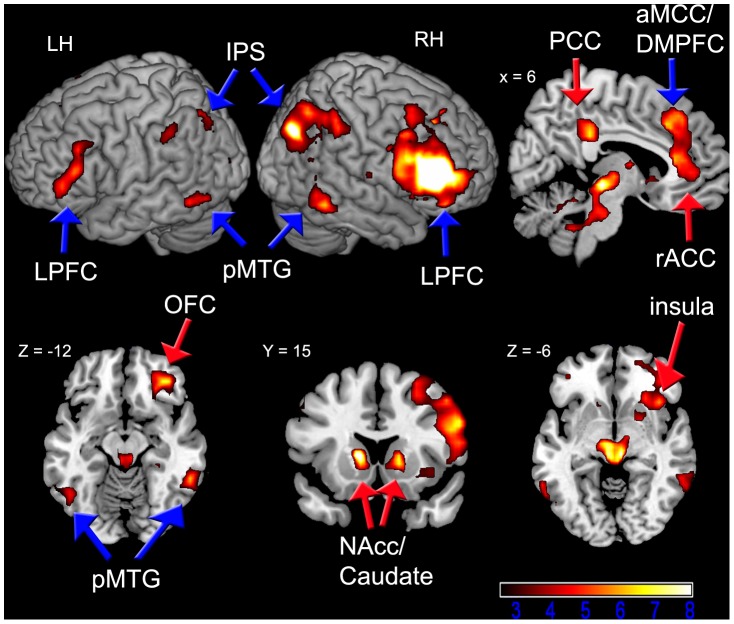
Regions Exhibiting Functional Connectivity with the IFS Across the Entire Time-Course (Z>2.57, p<.05 FWE cluster corrected for the whole-brain).Rule areas (blue arrows) include bilateral lateral prefrontal cortex (LPFC), anterior mid-cingulate cortex/dorsomedial prefrontal cortex (aMCC/DMPFC), posterior middle temporal gyrus (pMTG), and intraparietal sulcus (IPS). Reward areas (red arrows) include rostral anterior and posterior cingulate cortices (rACC, PCC), orbitofrontal cortex (OFC), caudate/nucleus accumbens (NAcc), and insula. The color scale denotes t-values, and the numerical values above the images correspond to MNI coordinates. For axial and coronal slices, the right hemisphere is on the right side of the image. LH = left hemisphere, RH = right hemisphere.